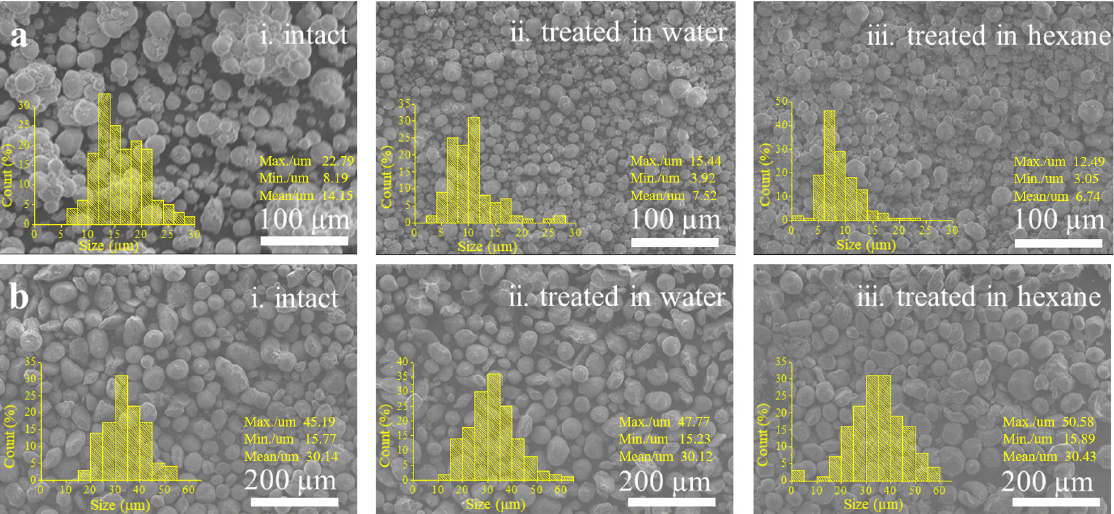
Figure 4. ( a ) SEM images and the size distribution statistics data of the pure SiO 2 aerogel microspheres of teos-SAMS-4.5 at different states: intact sample ( i ), dried sample after immersion in water for 5 days ( ii ), and dried sample after immersion in hexane for 5 days ( iii ). ( b ) SEM images of the PDMS- wrapped silica aerogel microspheres of teos-SAMS-4.5@PDMS at different states: intact sample ( i ), dried sample after immersion in water for 5 days ( ii ), and dried sample after immersion in hexane for 5 days ( iii ). Insets show the size distribution of the aerogel microspheres.